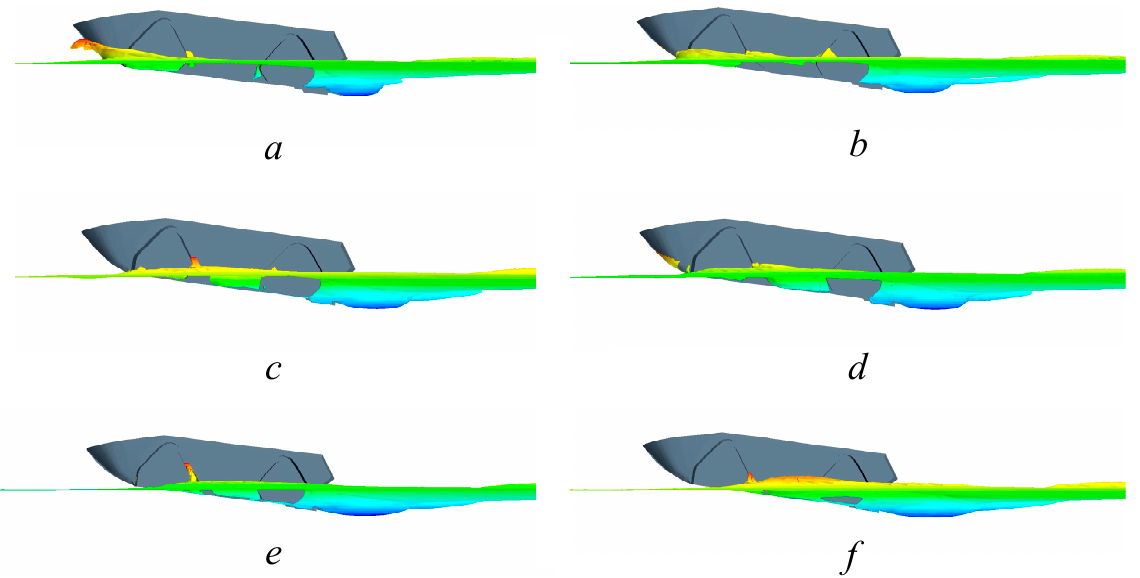
Figure 15. Sailing stage of HSAV at different Froude numbers (( a ) Fr = 0.72, Original; ( b ) Fr = 0.72, Flanks; ( c ) Fr = 0.86, Original; ( d ) Fr = 0.86, Flanks; ( e ) Fr = 1.0, Original; ( f ) Fr = 1.0, Flanks).